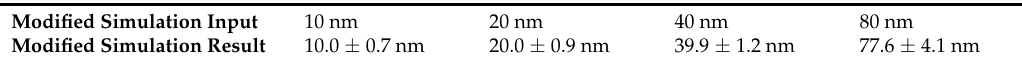
Table 1. Results for R q,o based on the modified simulation of roughnesses R q,r .